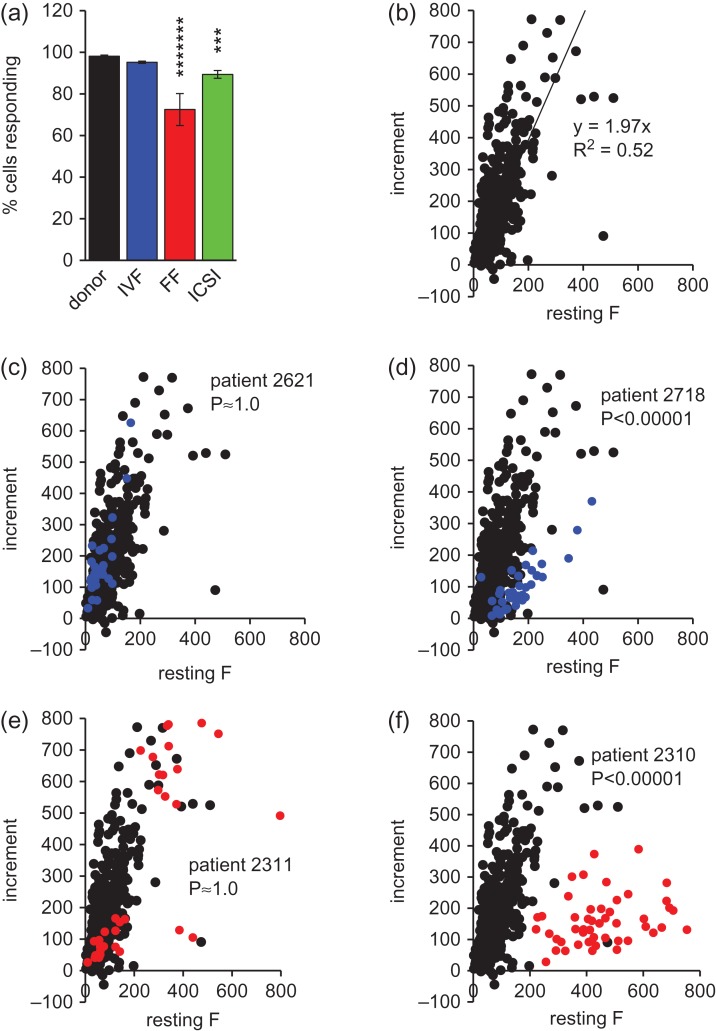
Single cell P4-induced [Ca2+]i transients. (a) Proportion of cells showing significant increase in fluorescence upon application of 3.6 μM P4. Asterisks indicate P < 0.005 (***) and P < 0.00005 (*******) with respect to donor samples. (b) Relationship between resting fluorescence and fluorescence increment for 749 cells from 21 donor samples. Line shows fitted regression (y = 1.97x; R2 = 0.52). (c–f) Show examples of relationship between mean resting fluorescence and mean fluorescence increment in two IVF(+ve) patients ((c) and (d); 32 and 37 cells, respectively; blue symbols); and two IVF-FF patient ((e) and (f) 52 and 53 cells, respectively; red symbols). In each of panels (c–f) black points and show data from donor cells (b) for comparison. Numbers in each panel are patient code (for comparison with Fig. 1) and P values show comparison of patient regression coefficient with that for donor cells.